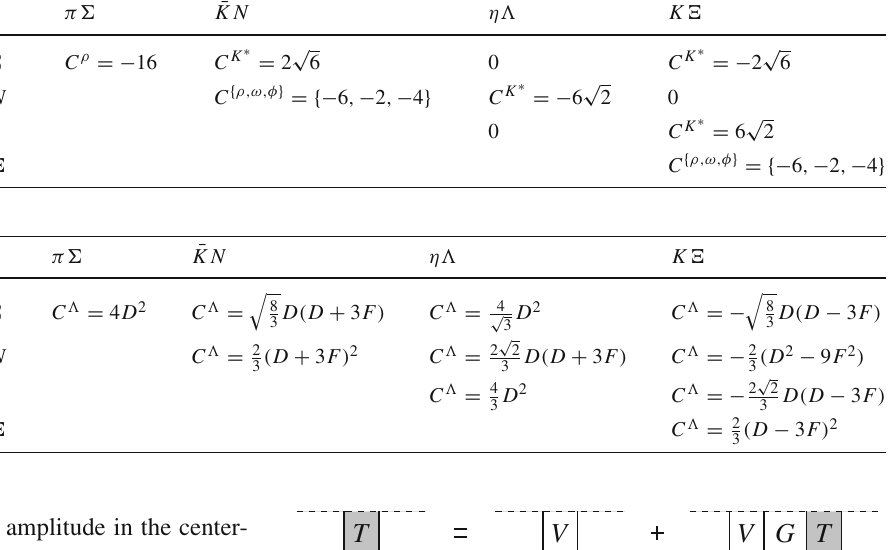
is visualized in Fig.